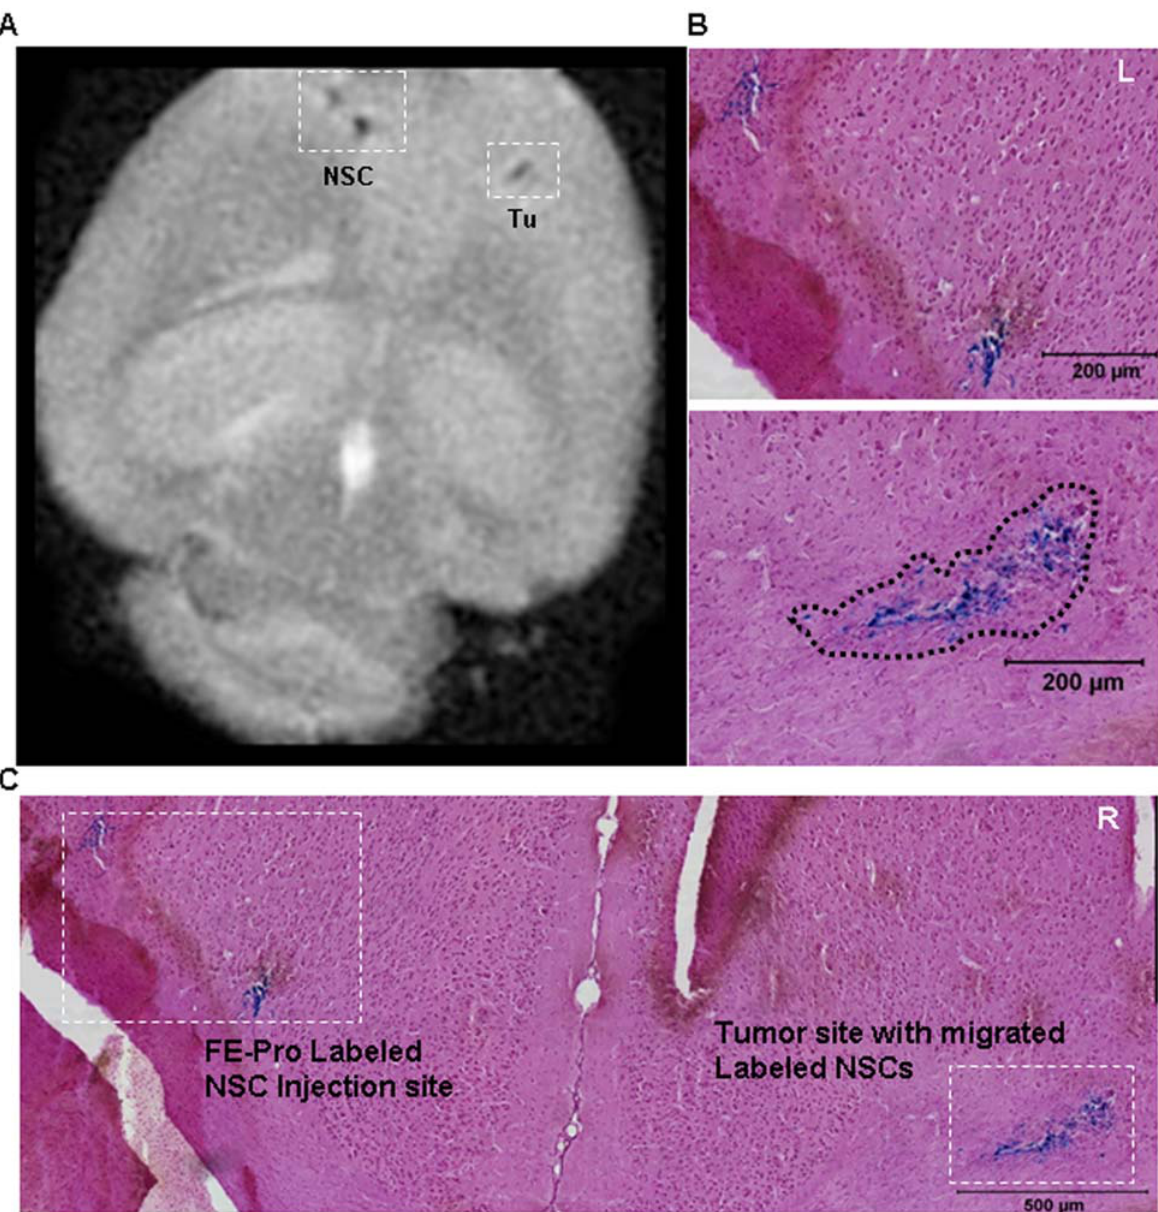
Figure 5. Sensitivity of MRI monitoring of FE-Pro-labeled NSCs targeting human glioma. (A) T2-weighted MR image of mouse brain in Fomblin, showing two distinct signal voids generated by FE-Pro-labeled NSCs that were injected , 200 m m apart from each other on the left hemisphere and a hypointense signal generated by FE-Pro-labeled NSCs that migrated to the contralateral tumor site (white dotted boxes). Approximately 600 FE-Pro-labeled NSCs constituted a detectable signal void. (B and C) Prussian blue stained section from the region shown in (A). Higher magnification images (B , tumor area denoted by black dotted line ) of the regions outlined in (C) , showing PB-positive labeled NSCs corresponding to the hypointense signal sites in (A) . MRI conditions: 7.0 Tesla, Rapid Acquisition Relaxation Enhancement sequence, 78 m m/pixel, 300 m m/slice, T R /T E =1500/23.1 ms. Scale bars=200 m m (B) , 500 m m (C) .